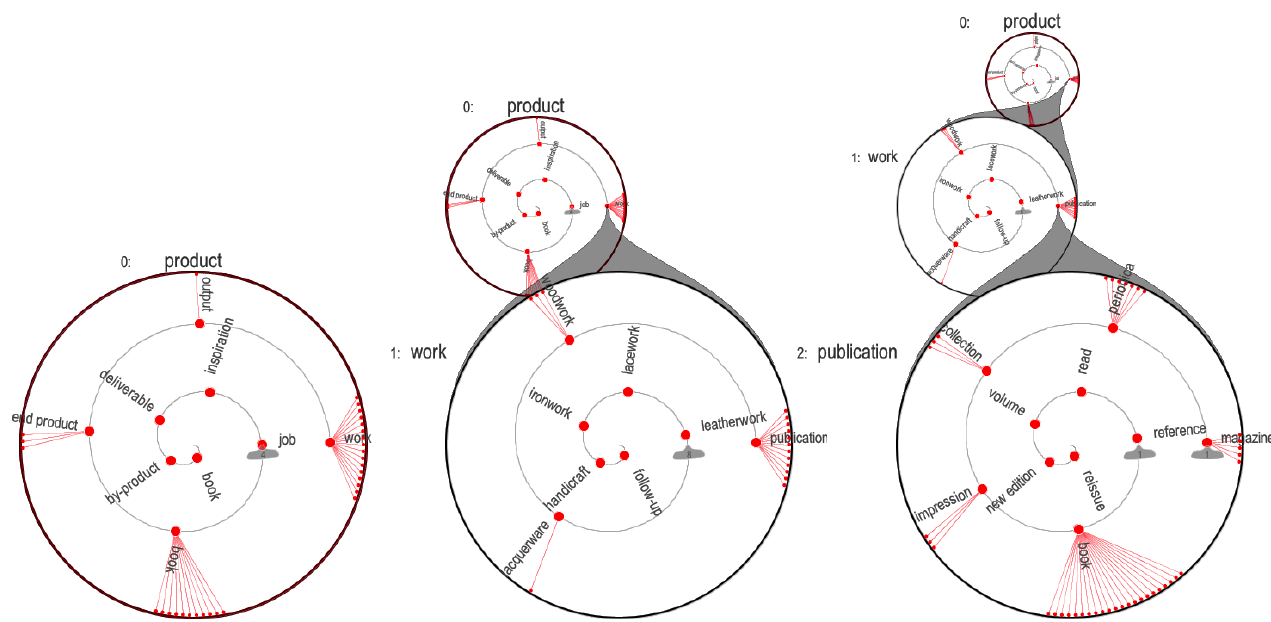
Figure 7. Drilling into a PaisleyTree: Each node circle in a PaisleyTree represents one node, with the bottom-most node representing the current node-of-interest. The node’s children are shown along a spiral in the node circle, while grandchildren are shown along the outer perimeter. By consecutively clicking on a sequence of children nodes the most recently selected child node becomes the current node-of-interest and expands into a new node circle, supporting drill down in the tree.